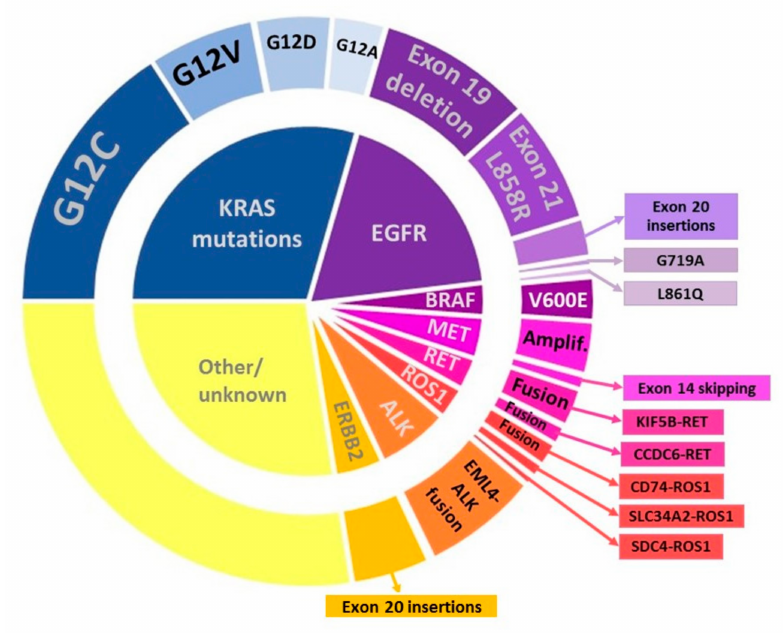
Figure 2. Molecular alterations in lung adenocarcinoma. Table 1. Summary of targeted therapeutics approved for NSCLC treatment. The table was created based on the FDA and EMA database of approved therapeutics for the treatment of NSCLCs positive for genetic alterations. FDA—The Food and Drug Administration; EMA—European Medicines